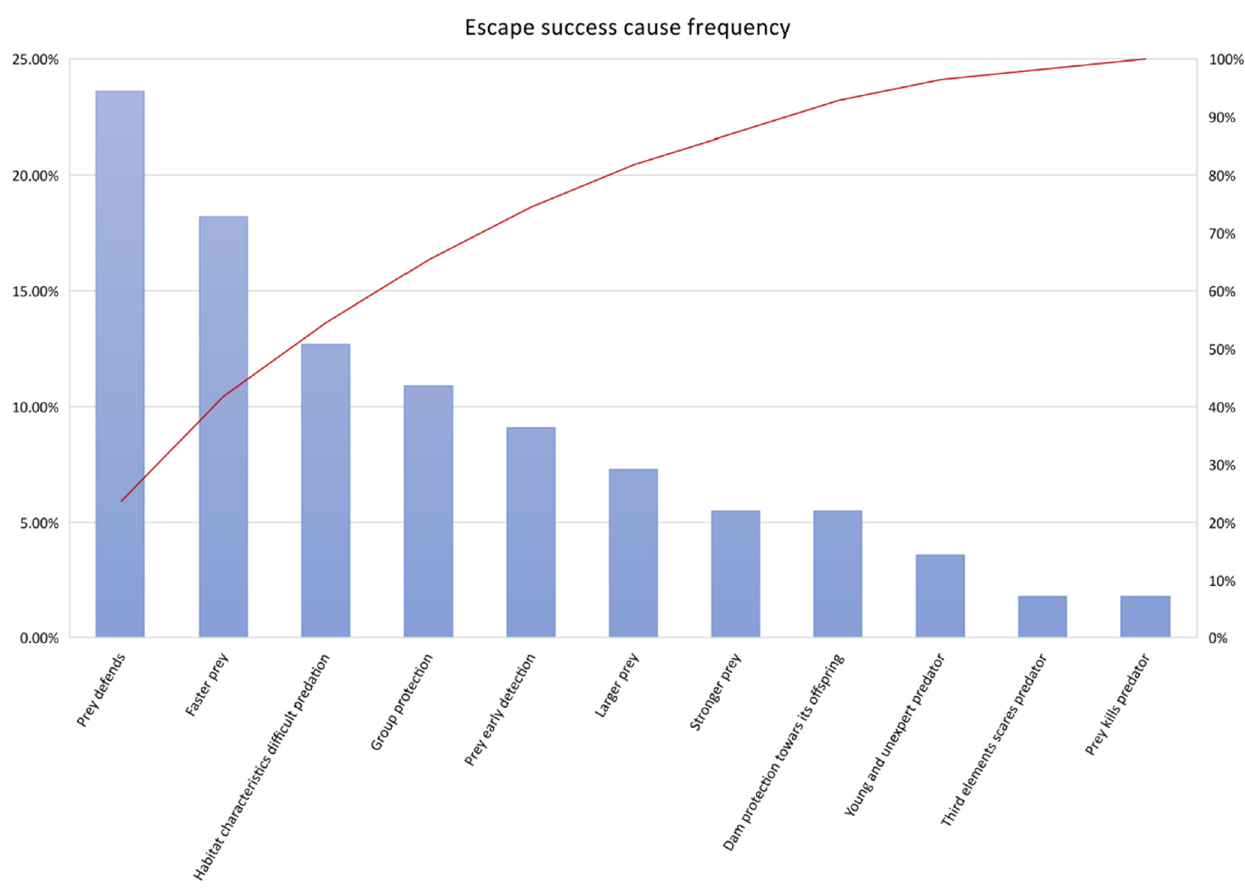
8 of 20 Table 3. Summary of results from Bayesian ANOVA to detect differences in mean probability of success in prey escape across environment-related factors and covariates. Factor/Covariate